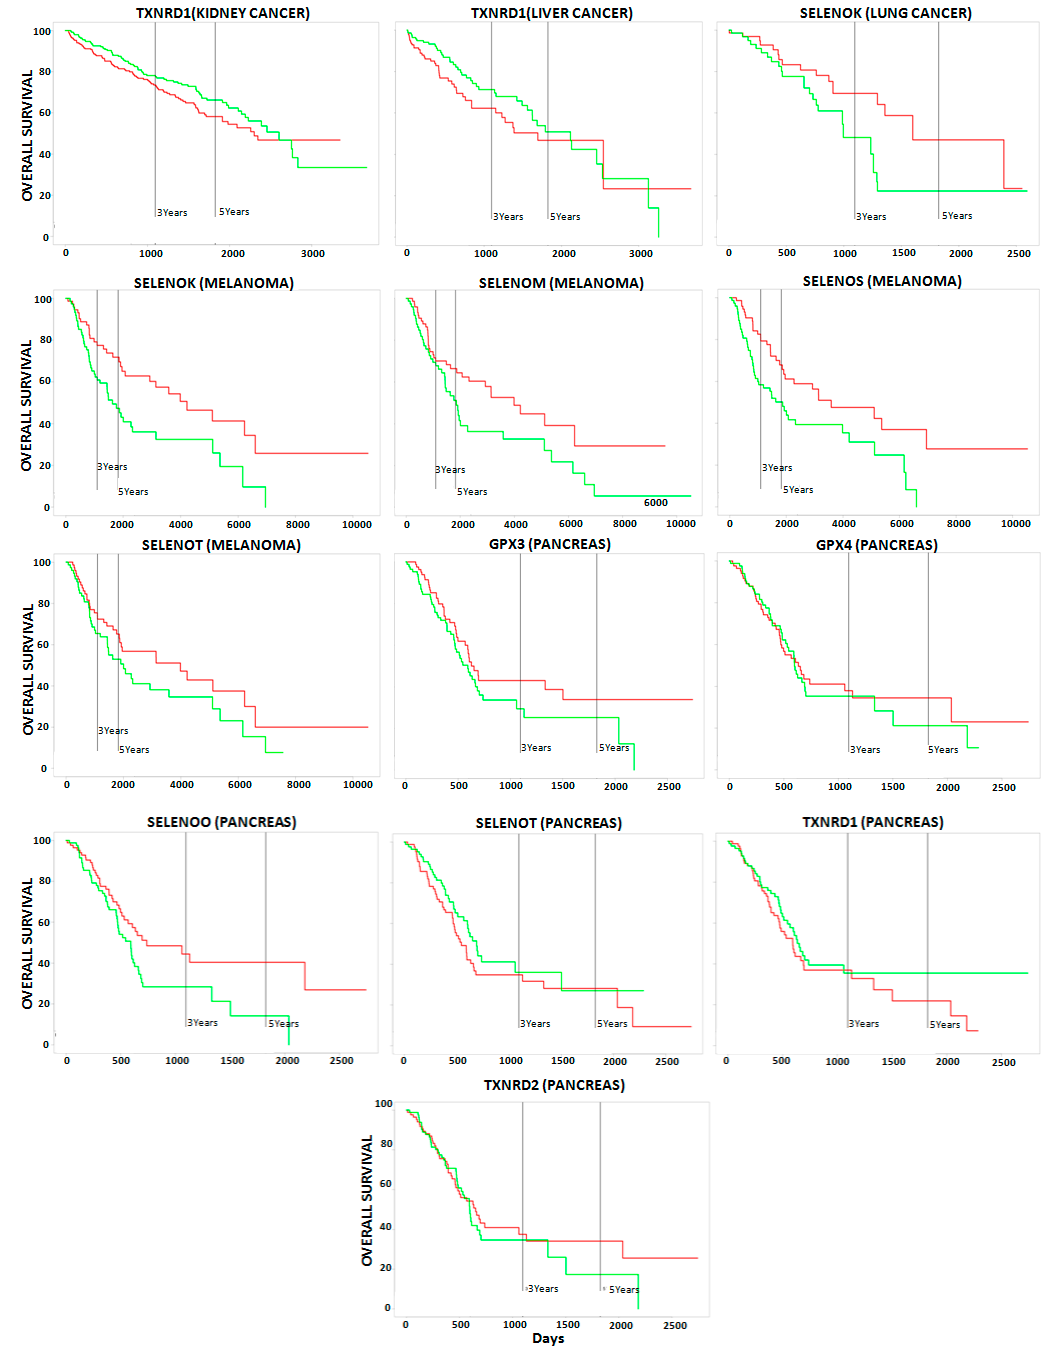
Figure 3. Kaplan-Mayer curves showing the overall survival (expressed in percentage) in solid cancer patients using the PROGgeneV2 online tool, in the case of high and low expression of selenoproteins, which are indicated by red and green curves, respectively.